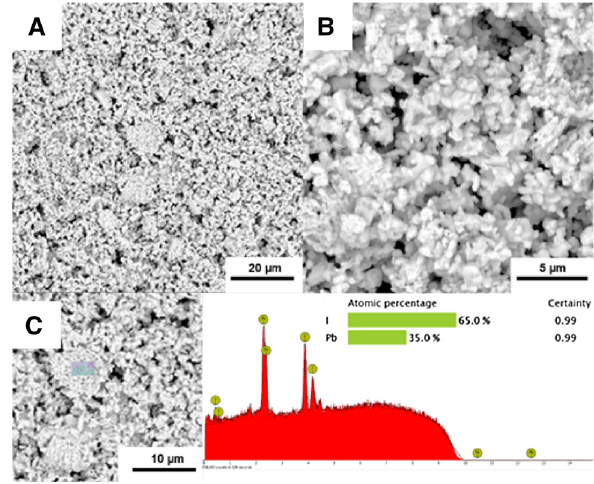
Fig. 6 SEM images and EDX spectrum of the degraded regions in the perovskite film stored at RH 50 % for 70 days, a at 20 l m scale, and b at 5 l m scale, and c EDX spectrum acquired in a square area of image c , scale bar is 10 l m